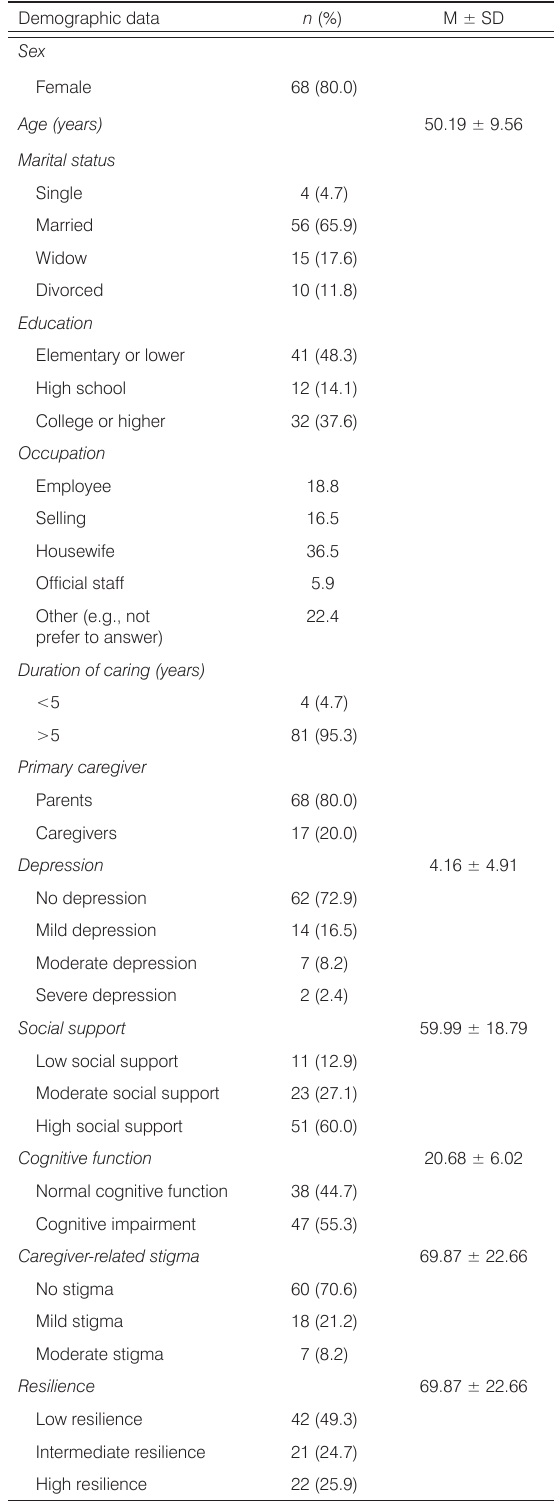
Table 1. Baseline